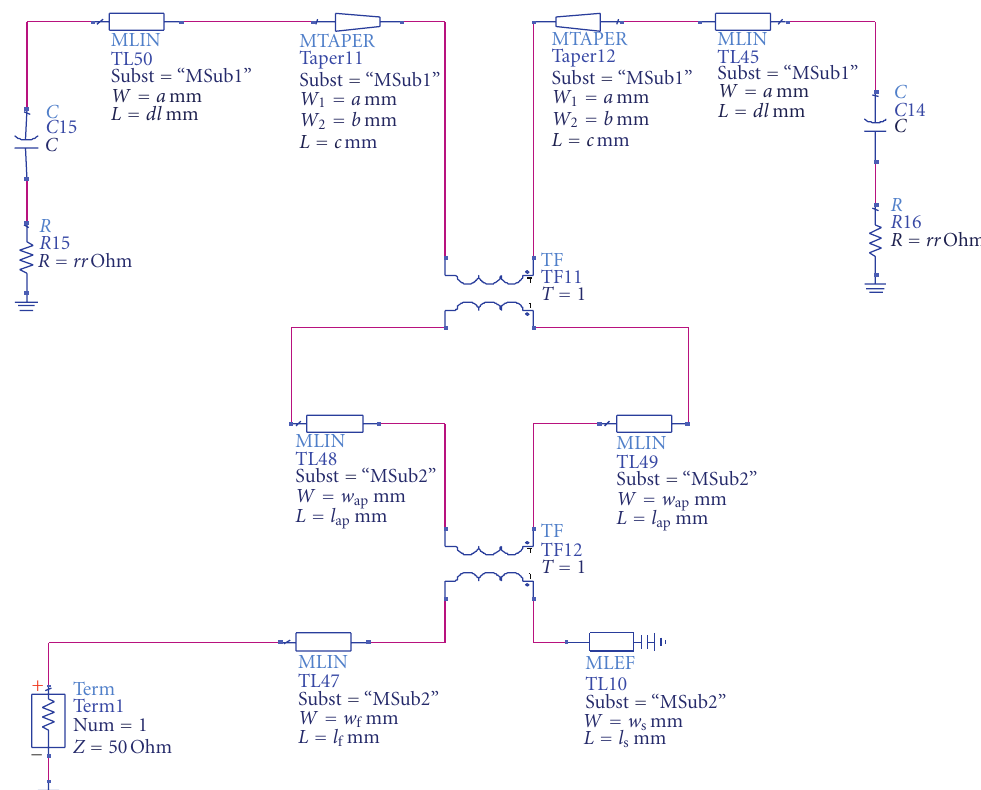
Figure 3: Equivalent circuit of the proposed